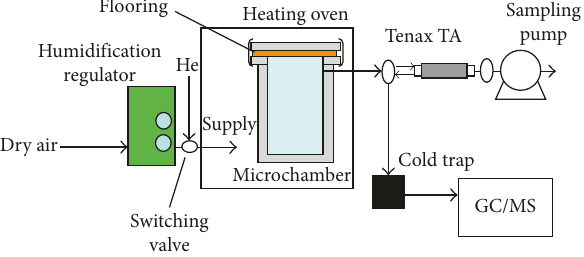
Table 2: Analytical conditions of the gas